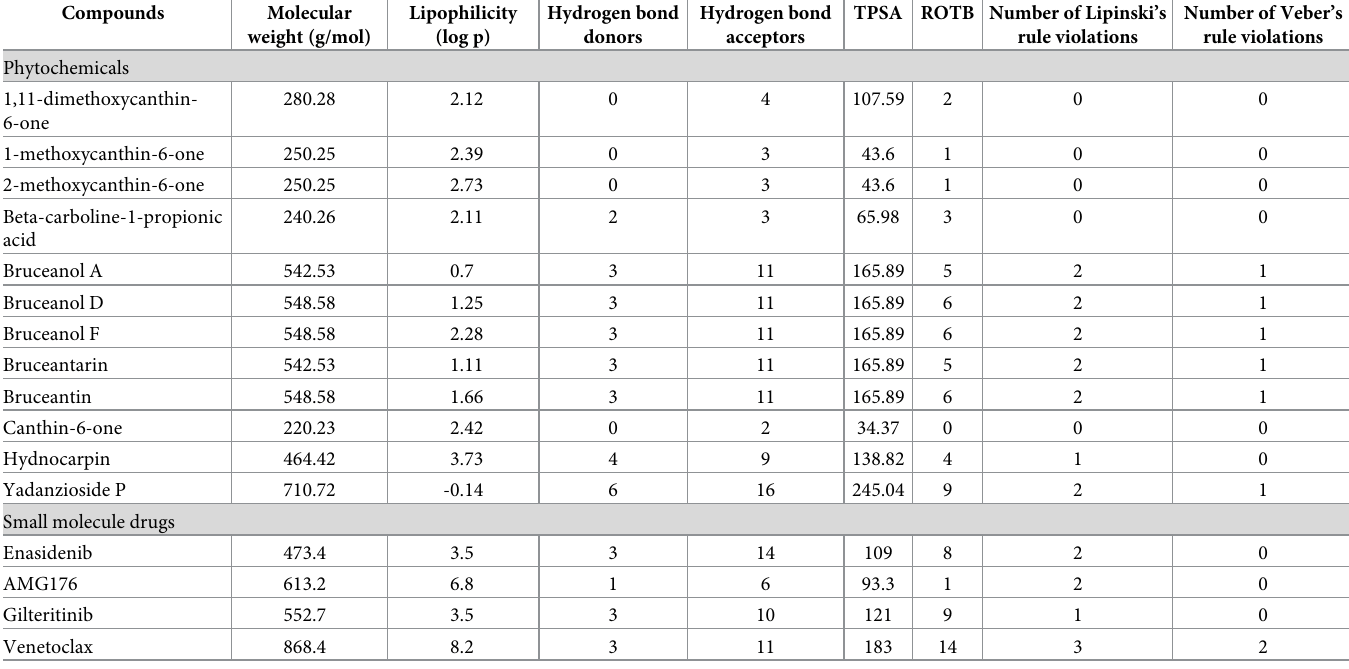
Table 2. Lipinski’s rule of five and Veber’s rule for drug-likeness analysis of selected phytochemicals and small molecule drugs.